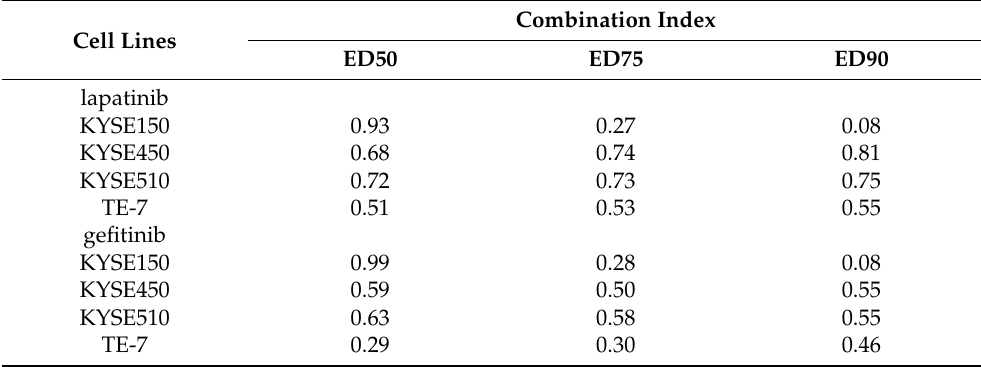
Table 2. Combination index values of gefitinib or lapatinib in combination with linsitinib in four ESCC